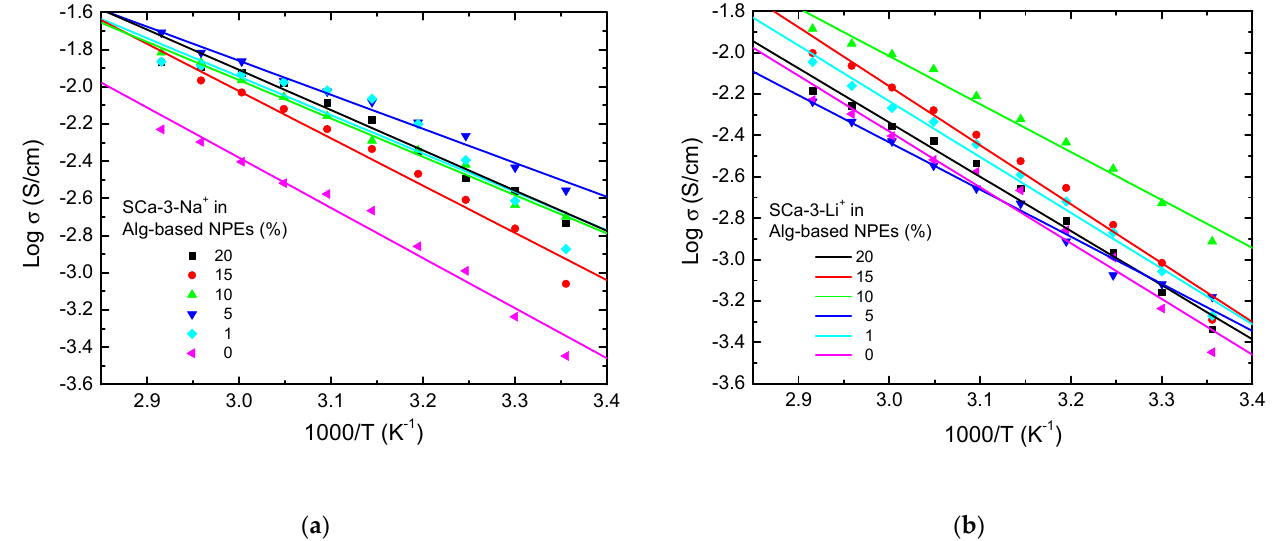
Figure 5. Log of conductivity in function of temperature for Alg-based NPEs with 0–20 wt% of ( a ) SCa-3-Na + and ( b ) SCa-3-Li + .